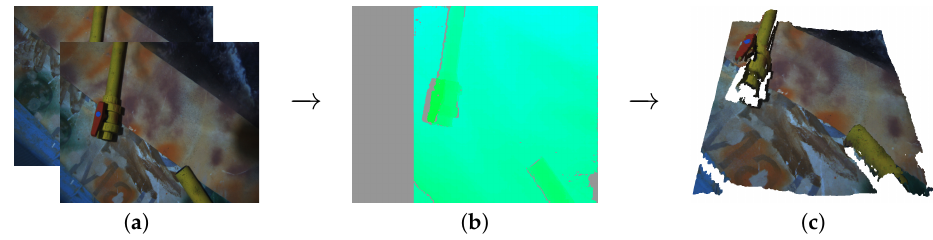
Figure 2. Data acquisition process. ( a ) left and right stereo images, ( b ) disparity image, ( c ) point cloud.